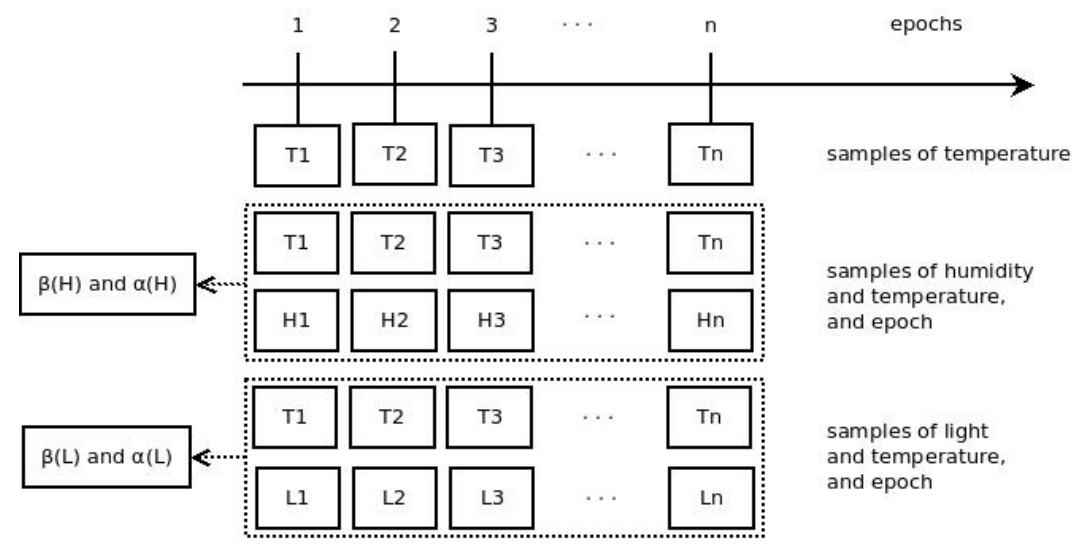
Figure 3. Operation of the monitoring system based on prediction proposed on this paper (multiple linear